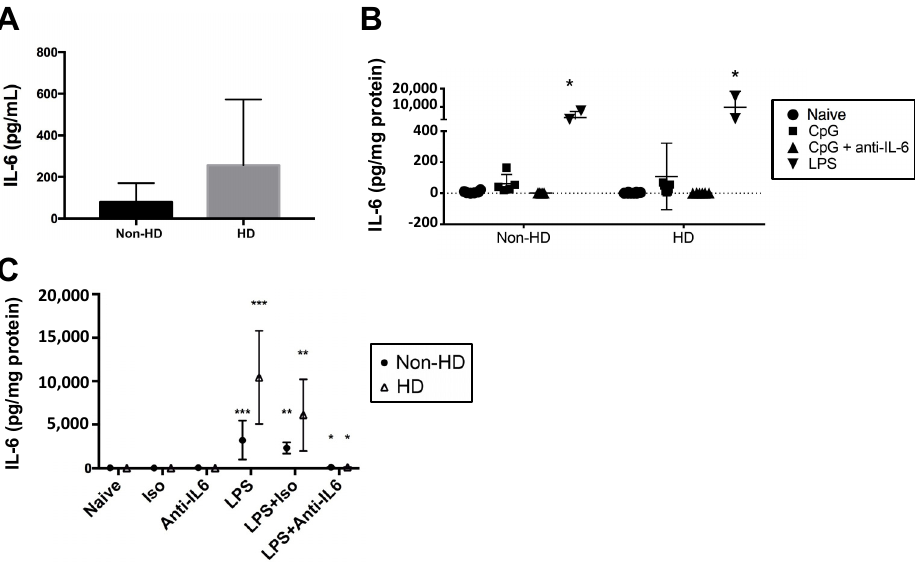
Figure 1. Interleukin-6 (IL-6) levels in non-Huntington’s disease (HD) and HD individuals. ( A ) Plasma was isolated from whole blood of individuals, and plasma IL-6 was measured by ELISA ( n = 5). ( B ) Peripheral blood mononuclear cells (PBMCs) were stimulated with CpG in the presence and absence of anti-IL-6 neutralizing antibody ( n = 7 non-HD individuals, n = 6 HD individuals). For a few subjects, a comparison between CpG and lipopolysaccharide (LPS) was made to optimize IL-6 stimulation conditions because it was noted that CpG-induced IL-6 levels were relatively low. * p < 0.05 as compared to the other treatment groups. ( C ) In follow-up studies, PBMCs from non-HD and HD individuals were stimulated with LPS or were left untreated (naïve) in the presence and absence of IL-6 neutralizing antibody or IgG isotype control; n = 6 for all treatments, except for those treatments that utilized LPS alone ( n = 2). * p < 0.05 as compared to LPS + Iso of same treatment group, ** p < 0.05 as compared to Iso, *** p < 0.05 as compared to Naïve. For ( B , C ), IL-6 was detected in supernatants by ELISA and normalized to mg protein in the culture well. Differences between groups and treatments were assessed by Student’s t -test ( A ) and two-way analysis of variance ( B , C ).